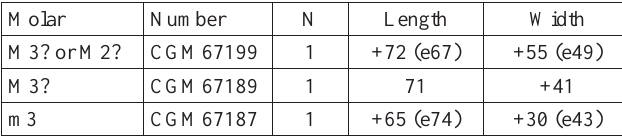
Table 1. Dimensions (in mm) of palaeomastodon molars (cf. Phio- mia sp.) from the BOTM at Minqar Tibaghbagh, Qattara Depression, Egypt. Abbreviations: e, estimated dimension; N, number of speci- mens; +, indicates dimensions of the fossil were originally greater. Molar Number N Length